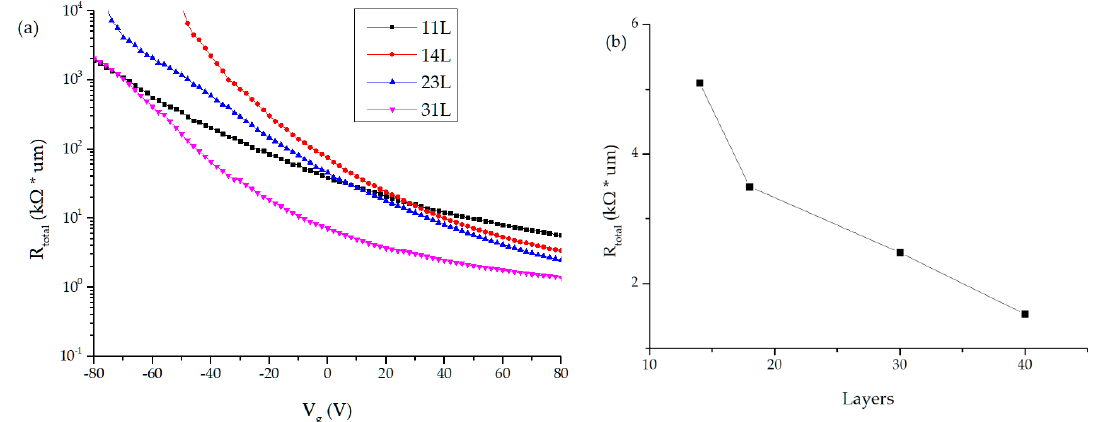
Figure 8. ( a ) FET’s R total of varying layers versus voltage gate; ( b ) R toral versus different layers.